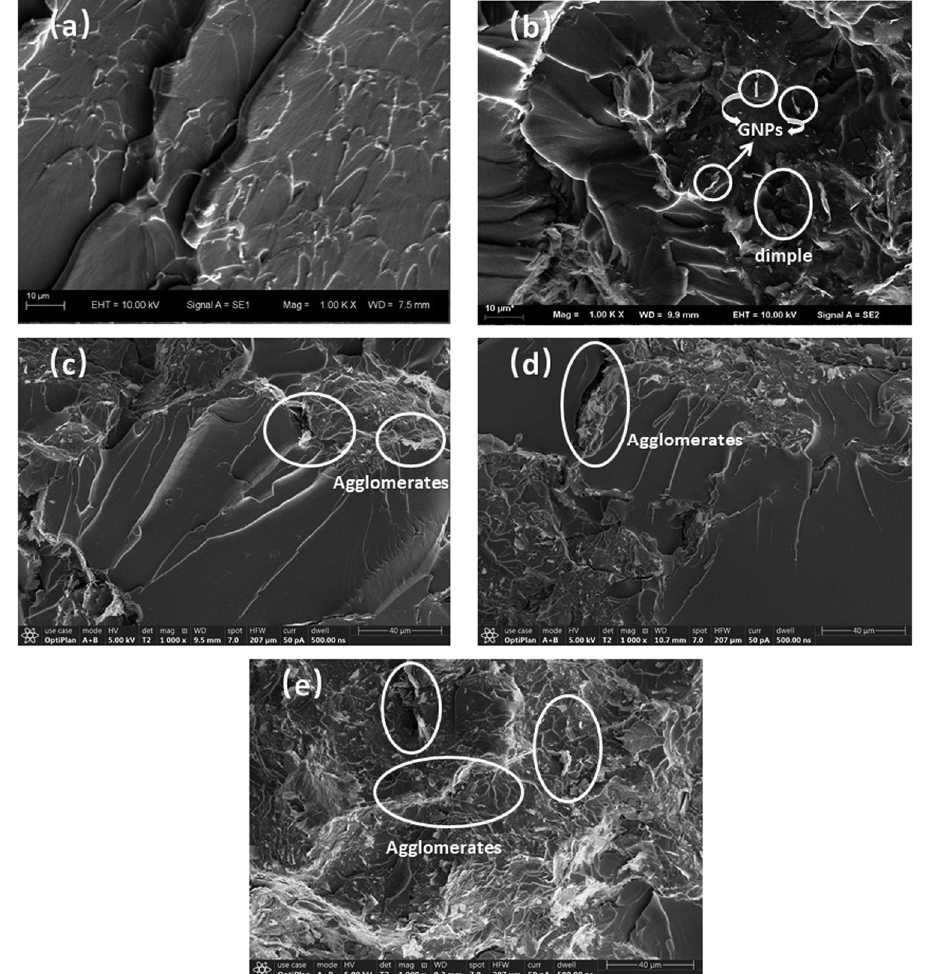
Figure 6: SEM images of bending fracture surfaces of ( a ) polyimine and GNPs - P composites with di ff erent contents of GNPs: ( b ) 0.5 wt%, ( c ) 1 wt%, ( d ) 1.5 wt%, and ( e ) 2